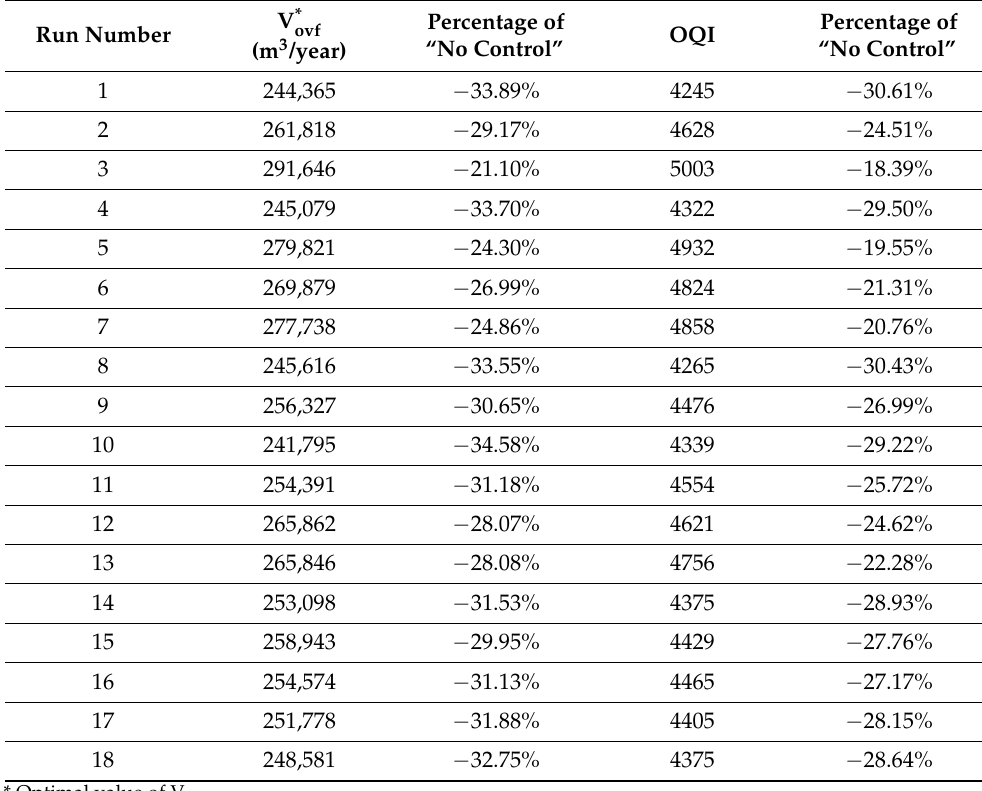
Table 18. 18 results of strategy #3 when minimizing V ovf .